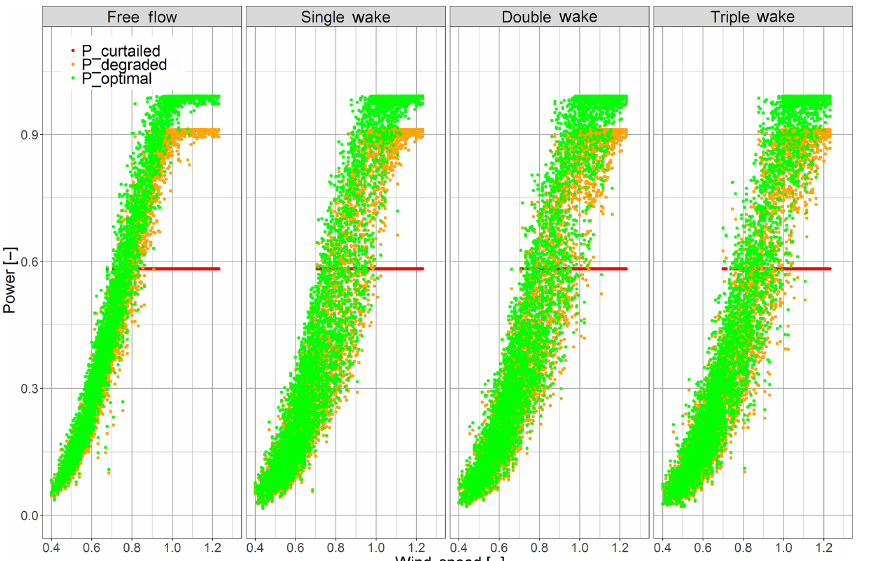
Figure 10. Scatterplot with normalized power as a function of the normalized wind speed for four turbines in one row with two error test cases. Green dots are the measured power values and represent optimal operation. The 8% degradation of the power output is shown with yellow dots. A curtailment at 58% is shown in